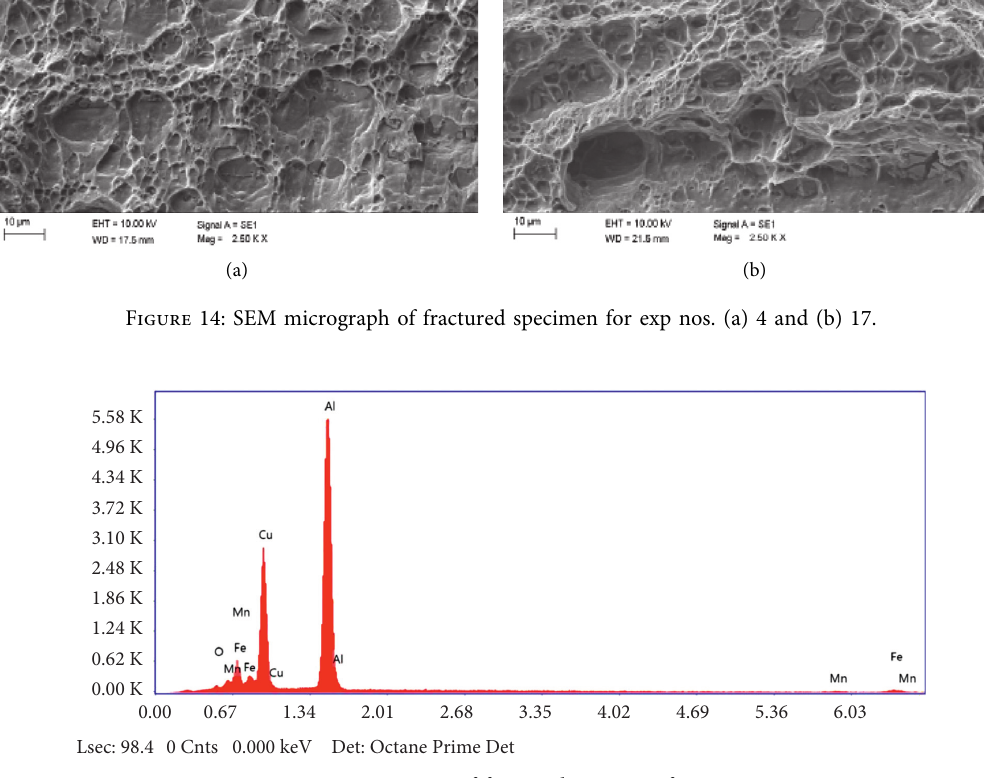
Figure 15: EDS spectrum of fractured specimen for exp no.